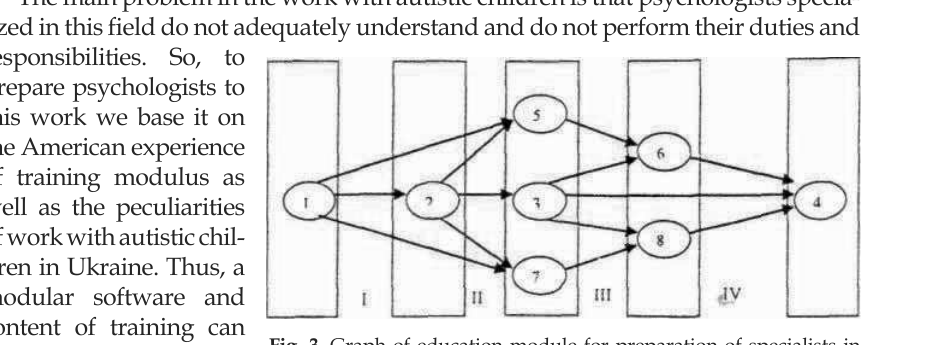
Fig. 3. Graph of education module for preparation of specialists in autism Source:Own